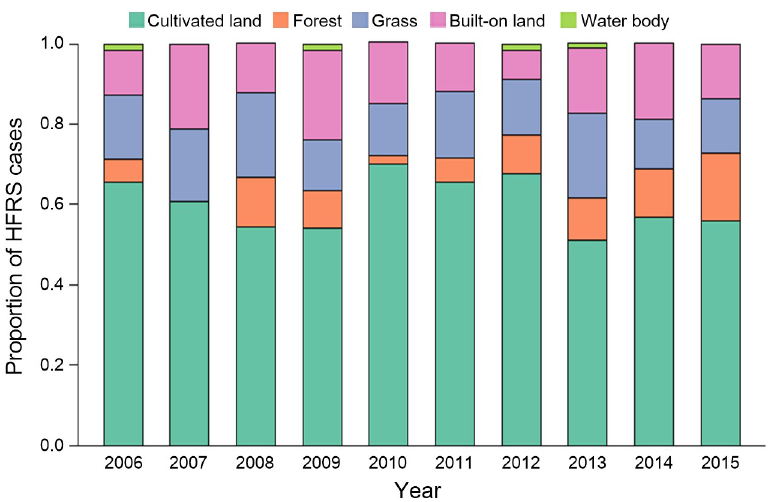
Fig 3. Annual proportion of HFRS cases among different land types in 2006–2015. Each column indicates the proportion of HFRS cases among the different land-use types (deep green: cultivated land; orange: forest; purple: grass; rose: built-on land; light green: water body) in a year.